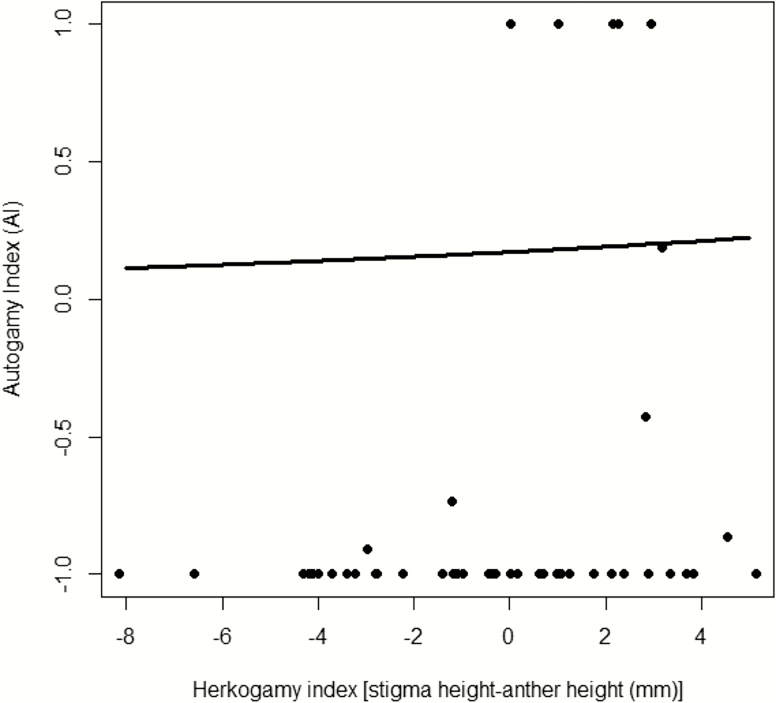
Relationship between the herkogamy index and the autogamy index (AI = (FSselfing − FSopen-pollination)/FSmaximum, where FS is fruit set). Line represents the estimate for the best model and the dots represent the AI for each study plant. Herkogamy index: P = 0.024.